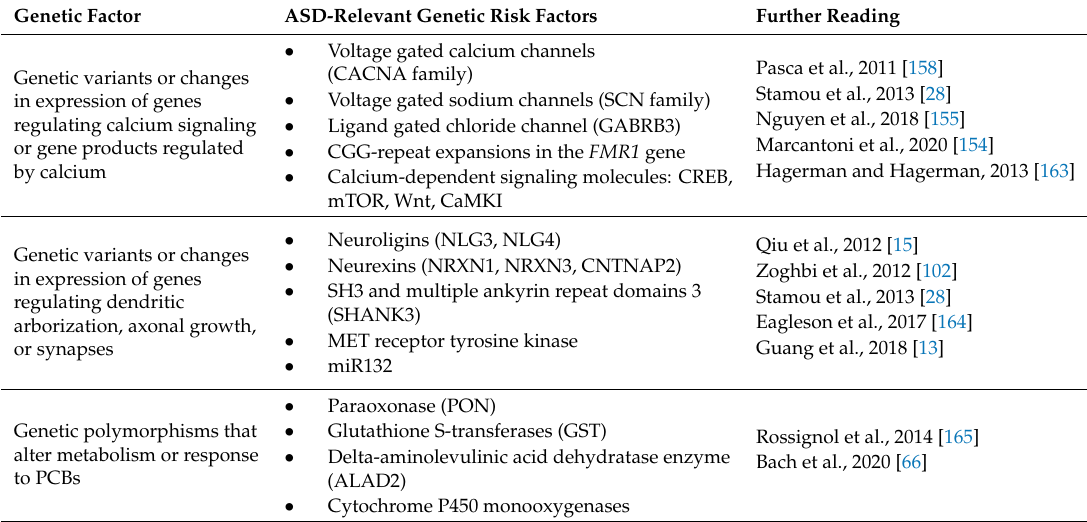
Table 1. Potential ASD risk genes that may interact with PCBs to increase ASD